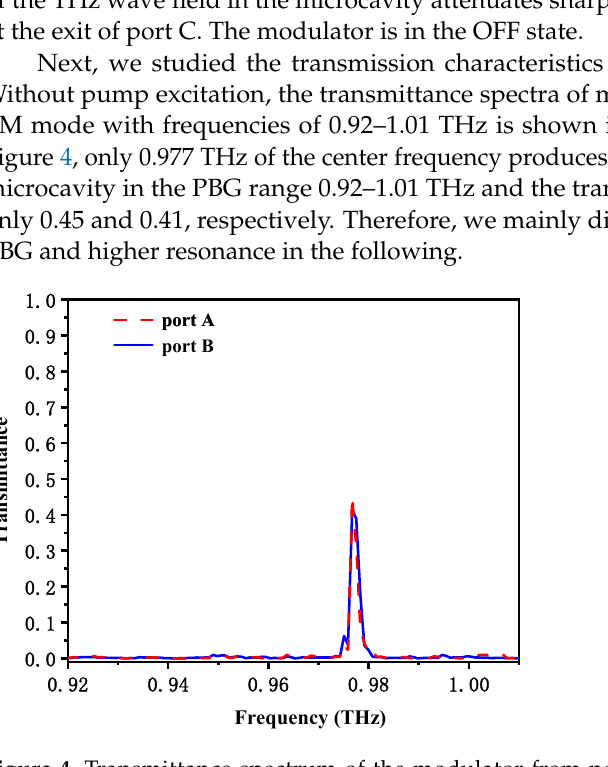
Figure 4. Transmittance spectrum of the modulator from ports A and B in TM mode without pump excitation.